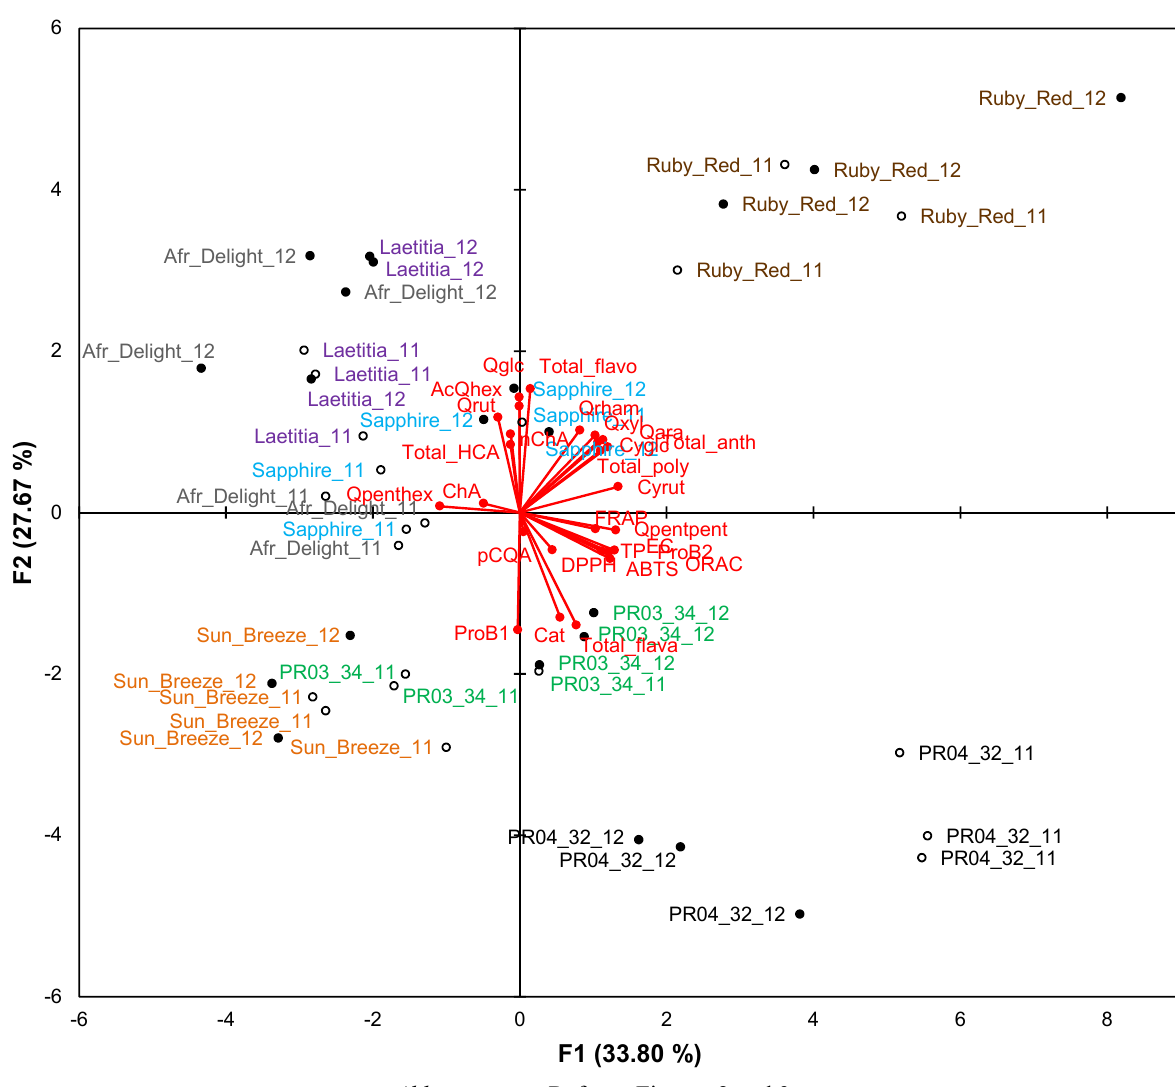
Figure 4. Principal component biplot of phenolic composition and total antioxidant capacity of ripe fruits from South African plum ( Prunus salicina Lindl.) cultivars and selections of two consecutive harvest seasons. Biplot (axes F1 and F2: 61.47